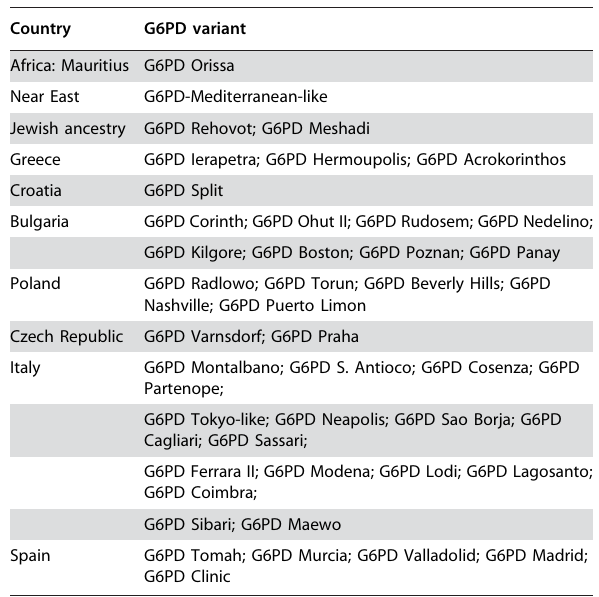
Table 3. Endemic G6PD variants in Europe, Near East,